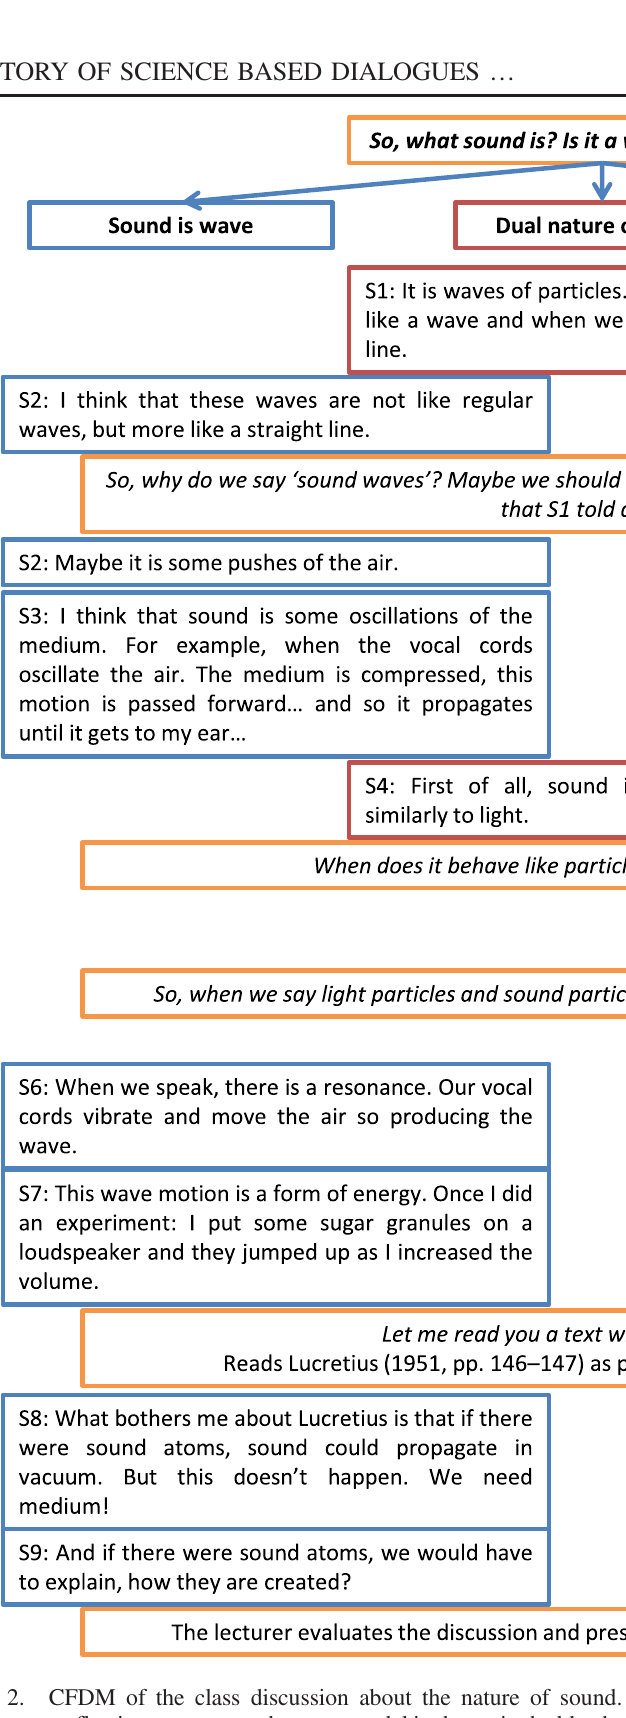
FIG. 2. CFDM of the class discussion about the nature of sound. The lecturer ’ s interventions are shown in the orange boxes. Responses reflecting a process — the wave model is shown in the blue boxes, while the corpuscular model is shown in the in green boxes. The CFDM structure is characterized by a zigzag